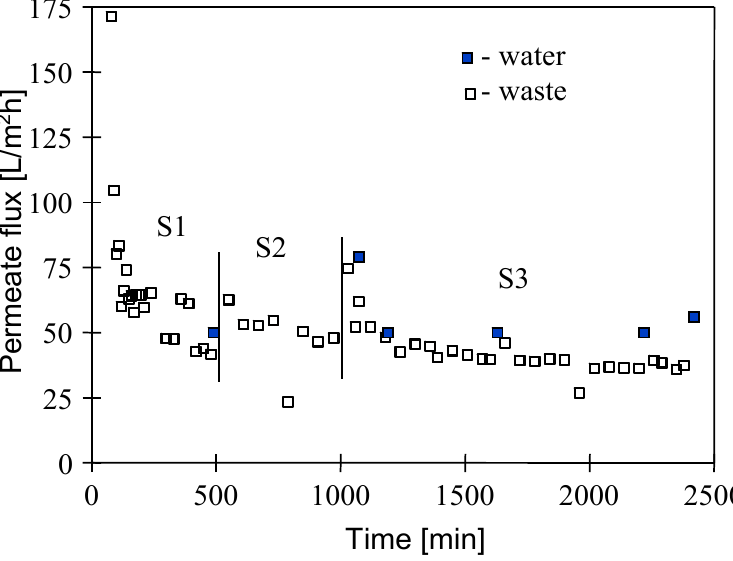
Figure 20. Changes in permeate flux and water recovery coefficient during long-term MF of oily wastewater #4. Module M2, TMP = 0.05 MPa, V F = 0.5 m/s, T = 22 °C.